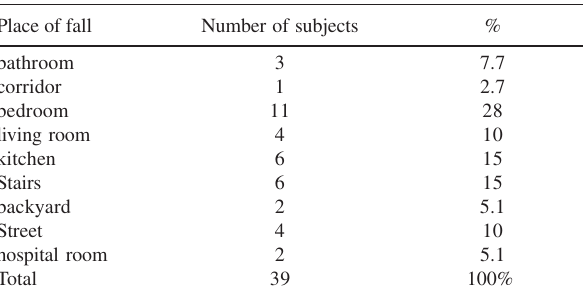
Table 3 - Preexisting diseases Preexisting